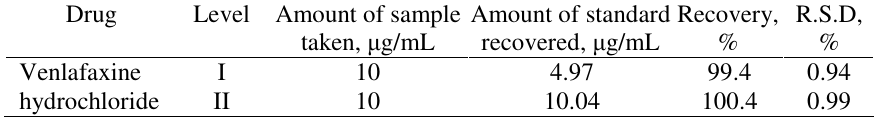
Table 8. Recovery data for the proposed RP-HPLC method (n=5).